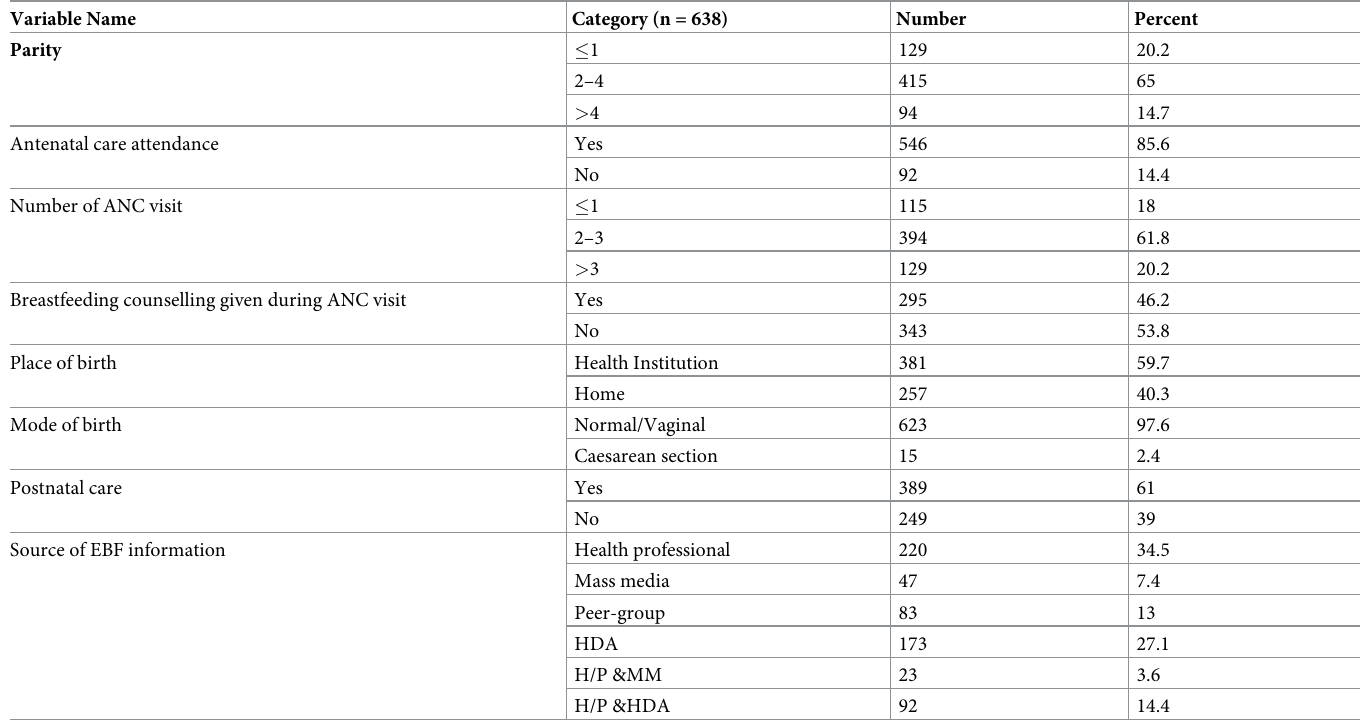
Table 2. Obstetric history and health service distribution of study participants (n =